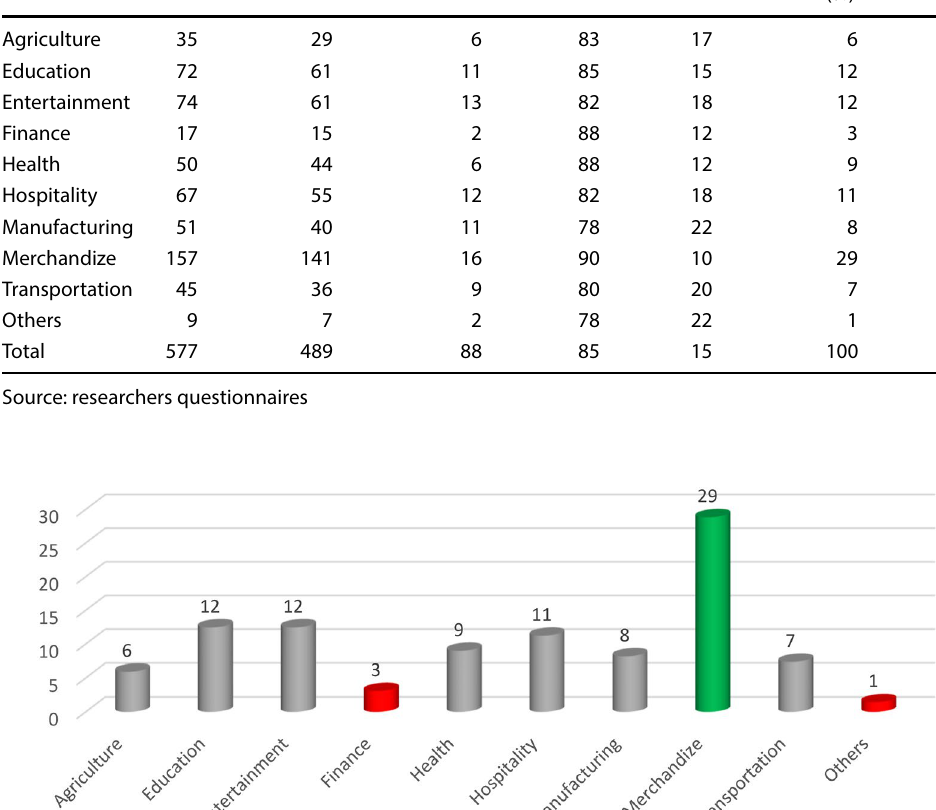
Table 4 Cross‑sectional analysis of SMEs’ preference for solar energy